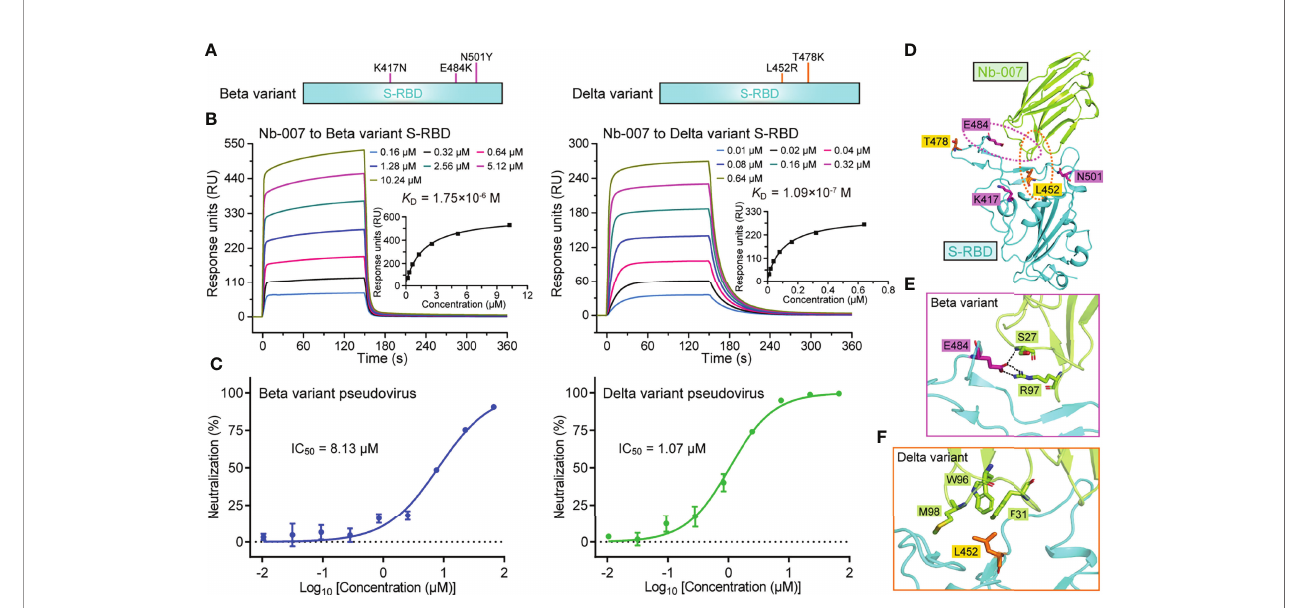
FIGURE 5 | Binding capacity and neutralizing activity of Nb-007 against SARS-CoV-2 variants. (A) Schematic view of the SARS-CoV-2 variants highlighting the mutations identi fi ed in S-RBD. Left panel: Beta variant. Right panel: Delta variant. (B) Af fi nity analysis of the binding of Nb-007 to the indicated SARS-CoV-2 variant S-RBD using SPR. The real-time binding kinetics are shown. (C) Inhibition of the pseudovirus entry by Nb-007 at the indicated concentrations for the SARS-CoV-2 variants. Each error bar represents the mean ± SD of triplicate. (D) An overview of the steric positions for those mutations identi fi ed in the SARS-CoV-2 variants relative to the bound nanobody. The three mutations in the Beta variant and two mutations in the Delta variant are shown as sticks and colored magenta and orange, respectively. Residues E484 and L452 are highlighted and their amino acid interaction details with the bound nanobody are further presented in (E, F) , respectively. (E) The interactions between S-RBD E484 and Nb-007 S27 and R97. (F) The interactions between S-RBD L452 and Nb-007 F31, W96, and